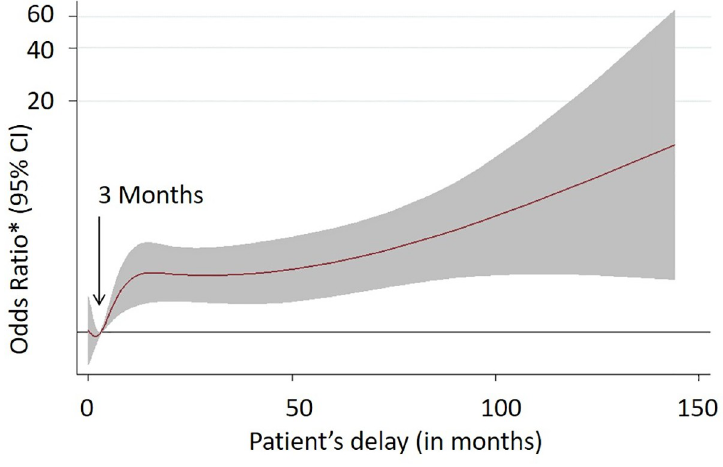
Fig 3. Non-linear relationship between patient delay and odds of G2D/G1D among adult leprosy cases at the time of diagnosis in five states of India during 2014–2016.